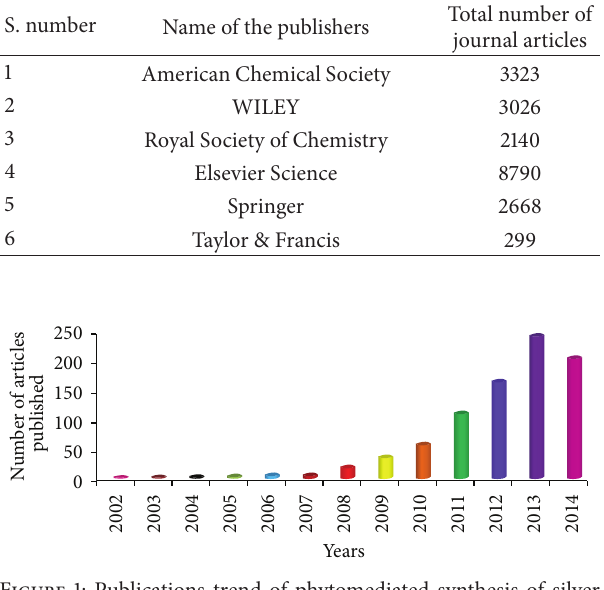
Figure 1: Publications trend of phytomediated synthesis of silver nanoparticles in journals under Scopus